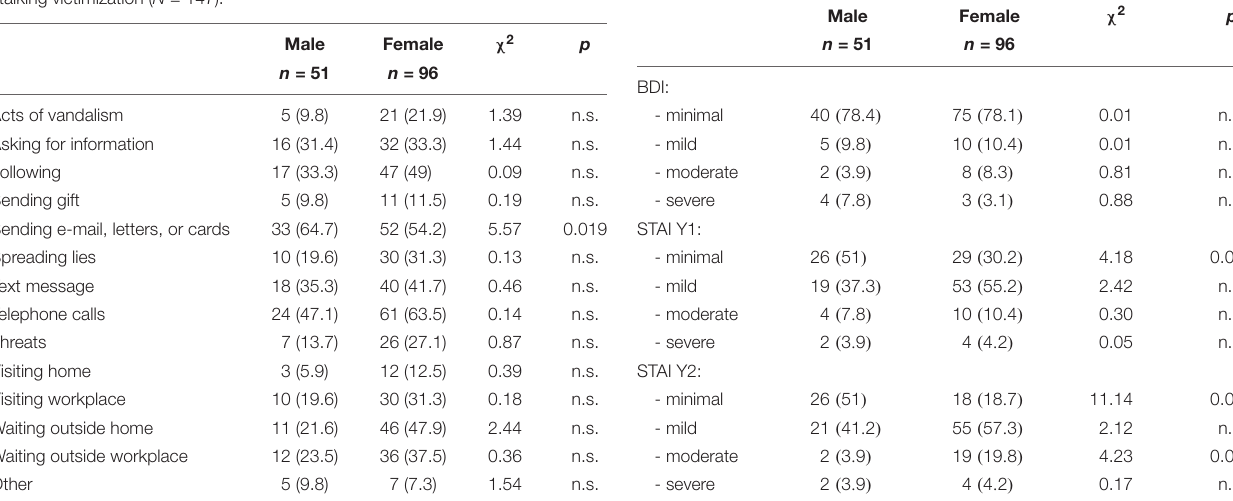
TABLE 3 | Level of depressive and anxiety symptoms indicated by the male and female HCPs experiencing stalking and domestic violence victimization ( N =